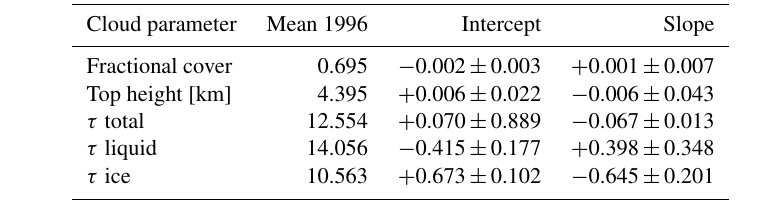
Table 1. Pan-Arctic mean values in 1996, trend intercept, slope, and bootstrapped 1 σ (given for 10-year time interval) for cloud fractional cover, top height, and optical thickness τ of Fig. 8.